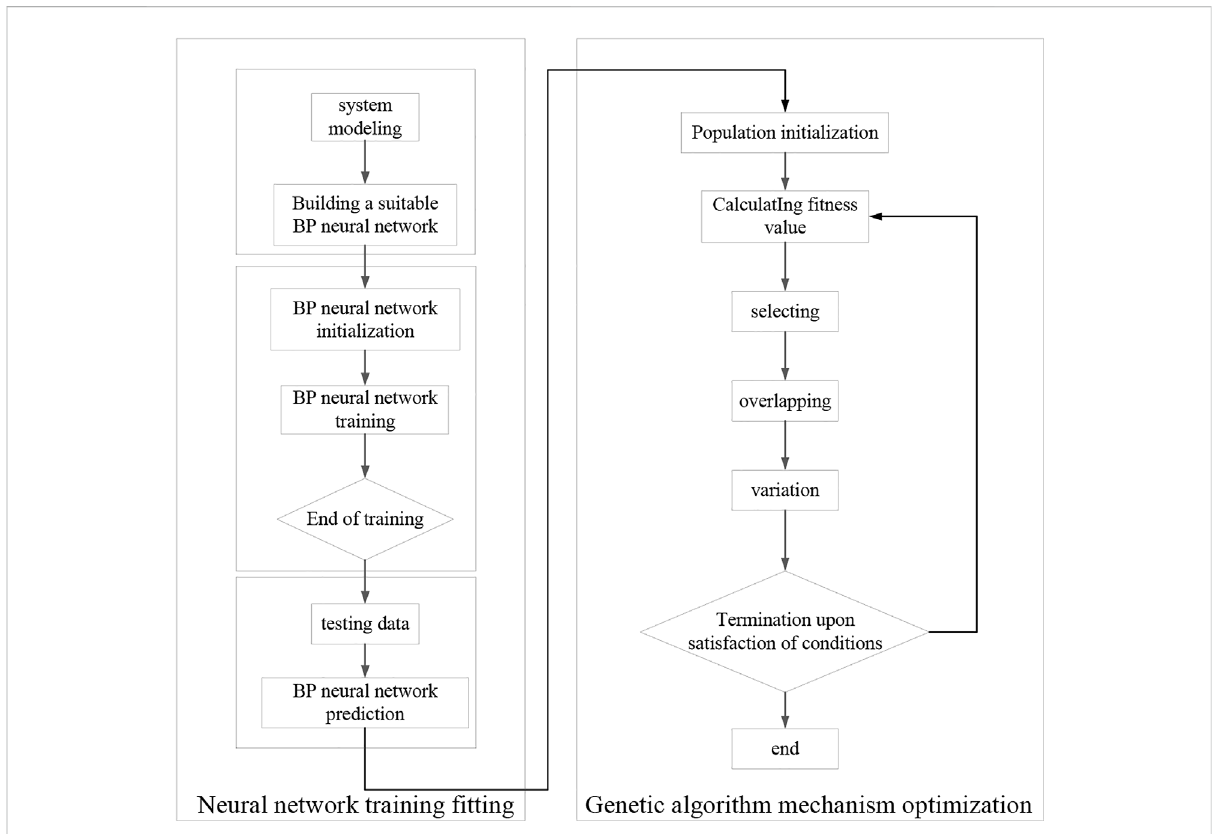
FIGURE 6 Flowchart of extreme value optimization of the neural network genetic